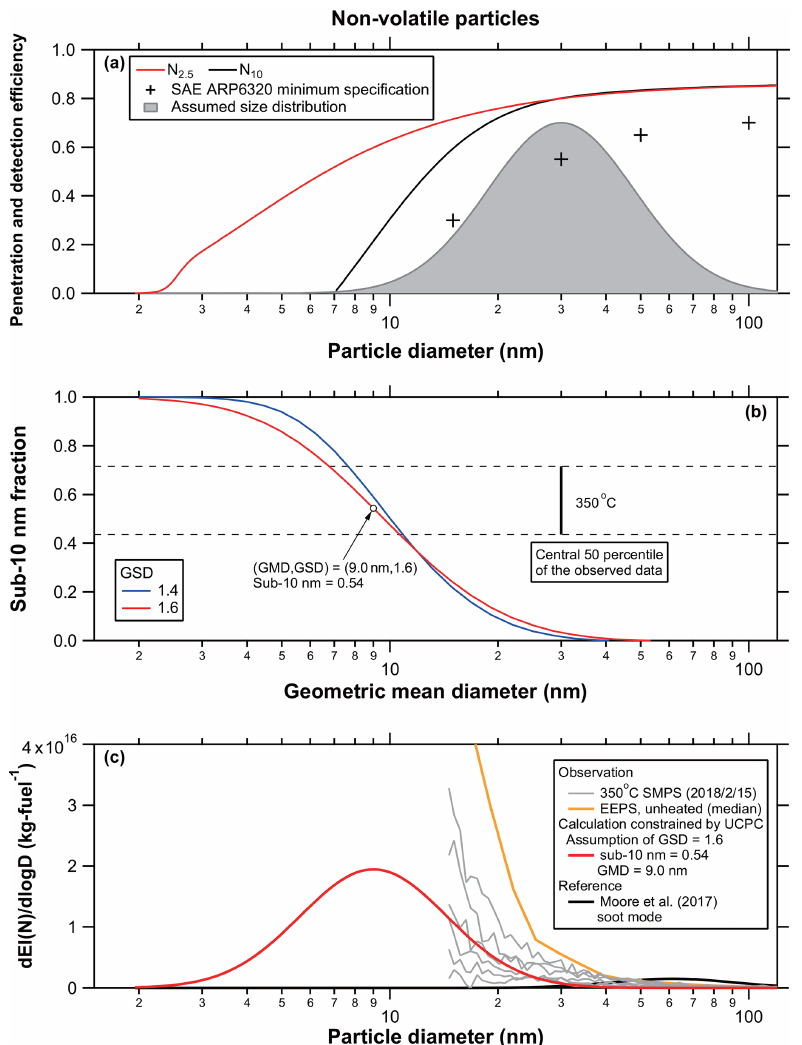
Figure 10. (a) Overall penetration and detection efficiencies for the 350 ◦ C heated N 2 . 5 and N 10 . The lower limit of the penetration efficiency through the VPR specified in SAE-ARP6320 is shown for comparison. The shaded area represents an example of the assumed particle number size distributions for calculating the number fraction of sub-10nm particles. (b) Number fraction of sub-10nm particles (1 − (cid:49)N 10 /(cid:49)N 2 . 5 ) obtained by convolution of the penetration and detection efficiency curves in (a) and assumed particle number size distributions having various GMDs and GSDs. The horizontal dashed lines indicate the central 50th percentile range (between 25th and 75th percentiles) of the observed data for the 350 ◦ C heated mode. The calculation results for the unheated (Fig. 9b) and 350 ◦ C heated modes were nearly identical because we assumed that the size dependency of the penetration efficiency of particles through the evaporation tube for the 350 ◦ C heated mode was the same as that for the unheated mode. (c) Examples of the particle number size distributions that can explain the observed median of (cid:49)N 10 /(cid:49)N 2 . 5 ratios for the 350 ◦ C heated mode (red). The size distribution of particle number EI with (GMD, GSD) = (61nm, 1.48), which corresponds to the average soot mode distribution (black) reported by Moore et al. (2017a), is shown for comparison. The size distributions of particle number EIs for the take-off plumes estimated from the 350 ◦ C heated SMPS on 15 February 2018 are also shown. The penetration efficiencies of particles through the sampling tubes and evaporation tube (Figs. 3 and S1) are incorporated in the SMPS